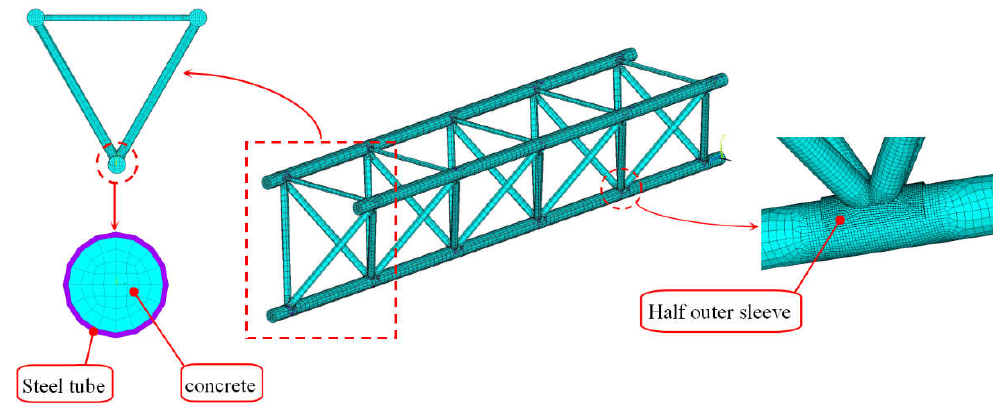
Figure 14. Finite element mesh of a Warren CHS tubular truss.